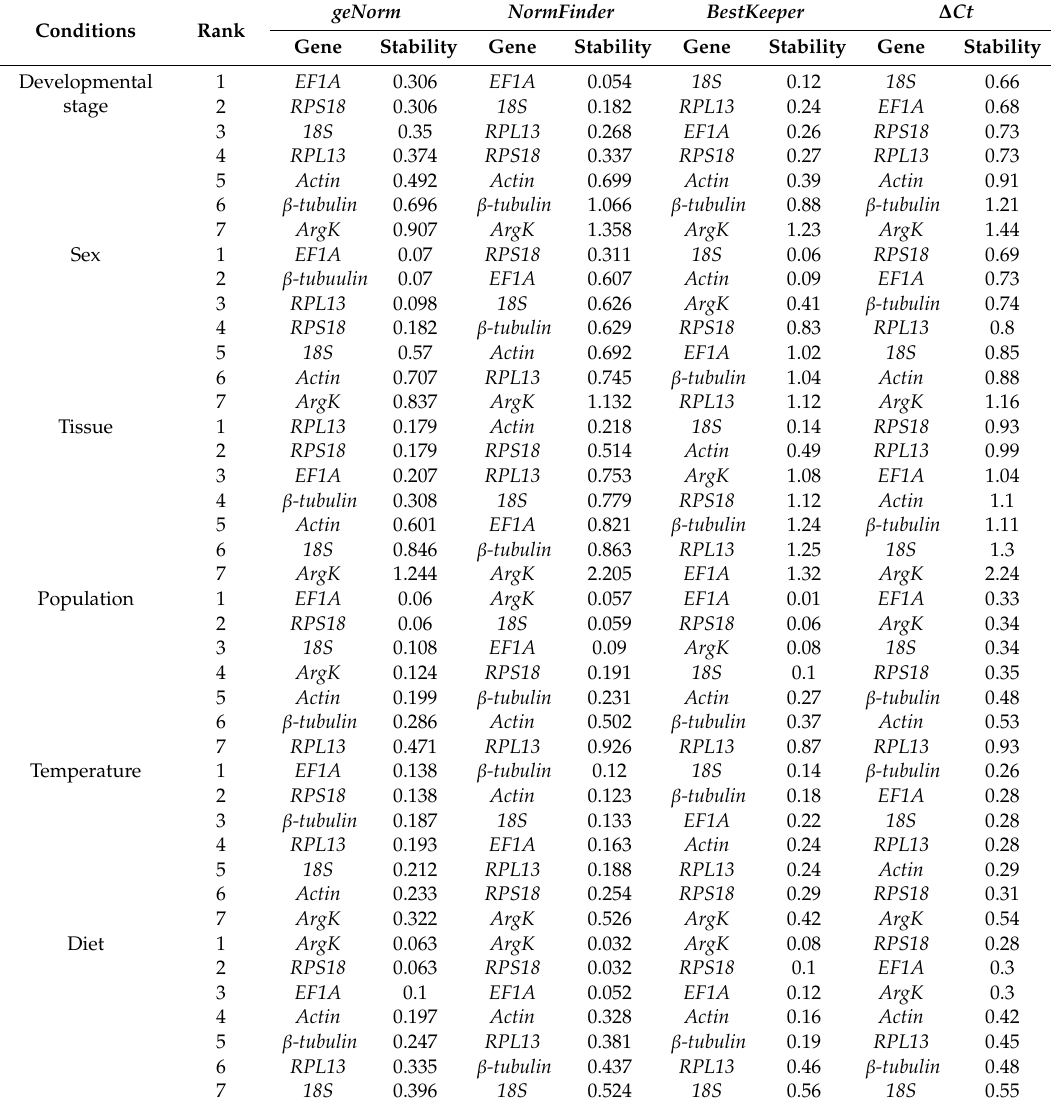
Table 2. Stability of candidate reference genes expression under di ff erent experimental conditions calculated by geNorm , Normfinder , BestKeeper , and the ∆ Ct method,